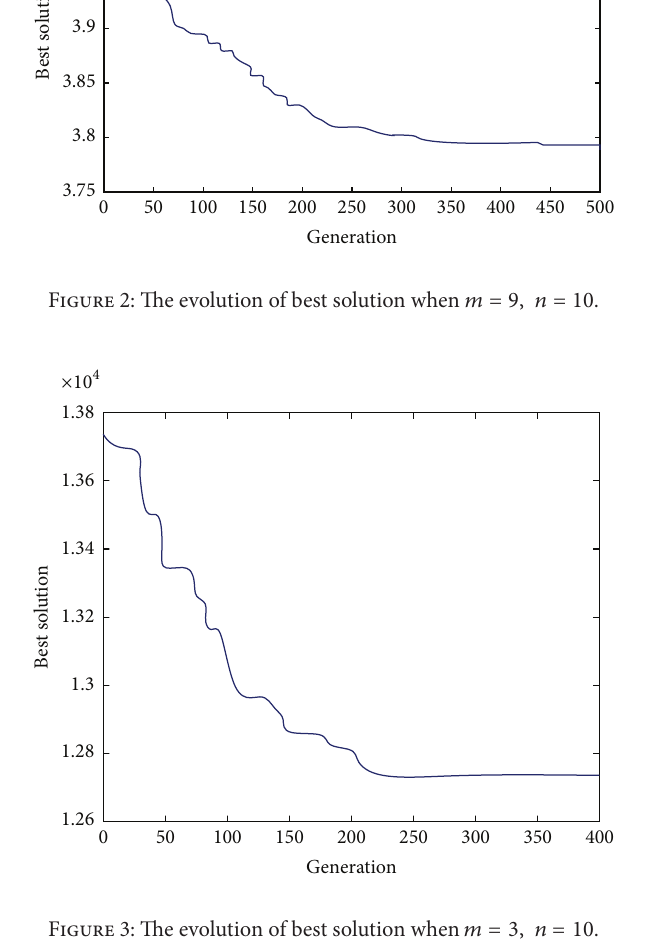
Figure 3: The evolution of best solution when 𝑚 = 3, 𝑛 = 10 .